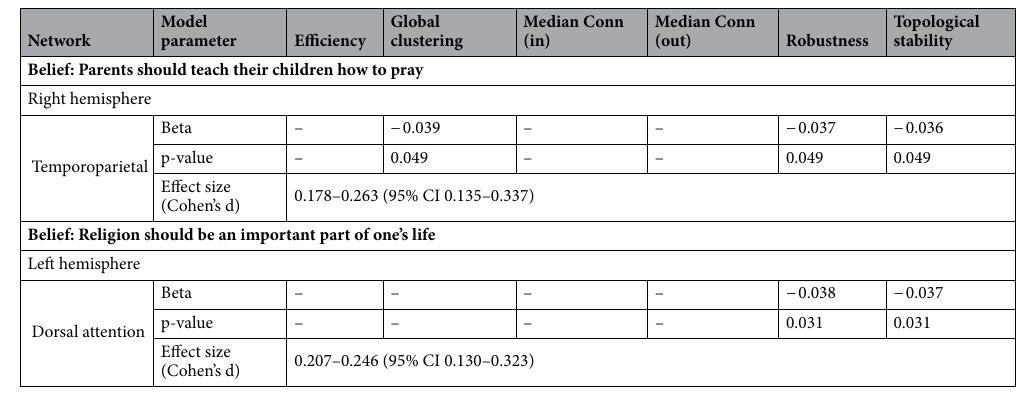
Table 6. Parameters of models assessing the relationship between the belief that ‘parents should teach their children how to pray’ and ‘ religion should be an important part of one’s life’ and individual network properties. Across properties, effect sizes (Cohen’s d) were calculated with strength of belief = 1 (not at all) as the reference, with adjustments for unequal sample sizes. A range of effect sizes across properties, and 95% confidence intervals (CI) are